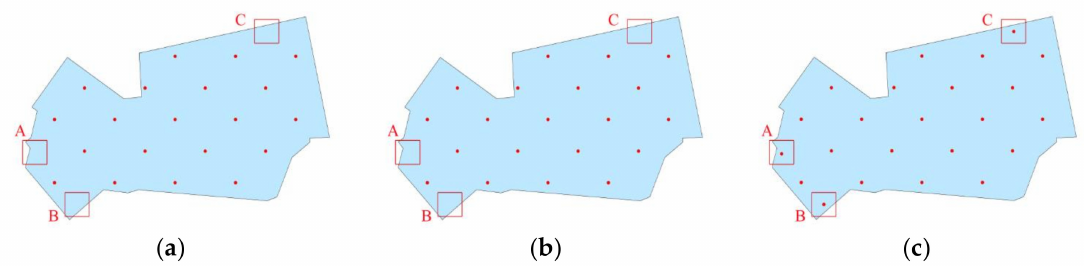
Figure 12. Regular area 1. ( a ) Filling using the traditional three-square type method. ( b ) The effect of the filling method based on simple segmentation. ( c ) The effect of the method proposed in this paper.